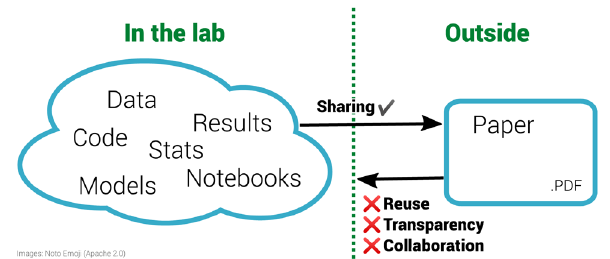
Figure 1. The inverse problem in reproducible research. The left half of the diagram shows a diverse range of materials used within a laboratory. These materials are often then condensed for sharing with the outside world via the research paper, a static PDF document. Working backwards from the PDF to the underlying materials is impossible. This prohibits reuse and is not only non- transparent for a specific paper but is also ineffective for science as a whole. By sharing the materials on the left, others outside the lab can enhance this